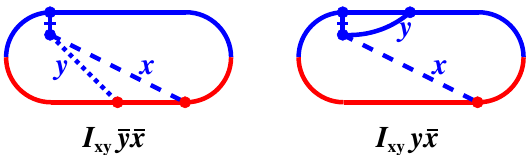
Figure 2 . Two examples of interference contributions involving a longitudinally polarized gluon, represented by the vertical line crossed by a bar. The line is drawn vertically because the interaction is instantaneous in (lightcone) time.